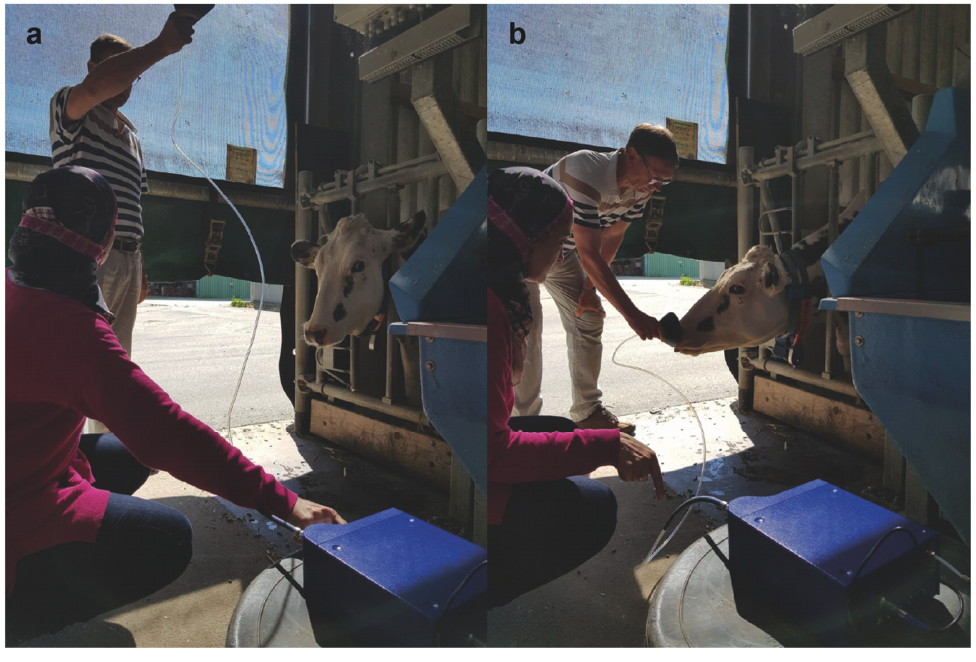
Figure 3. Sampling using the MENT-EGAS prototype. ( a ) Environmental sampling in the barn. ( b ) Exhaled breath sampling.